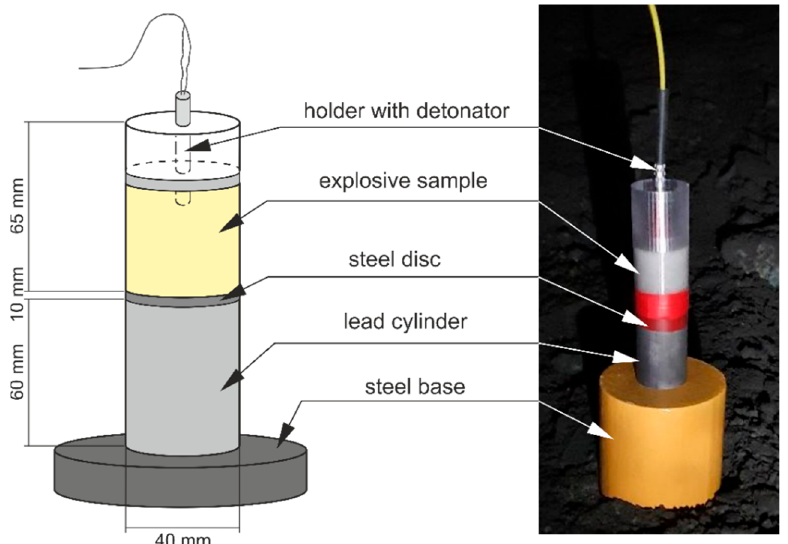
Figure 7. Scheme ( left ) and view of the sample ( right ) for determining brisance via the Hess method.